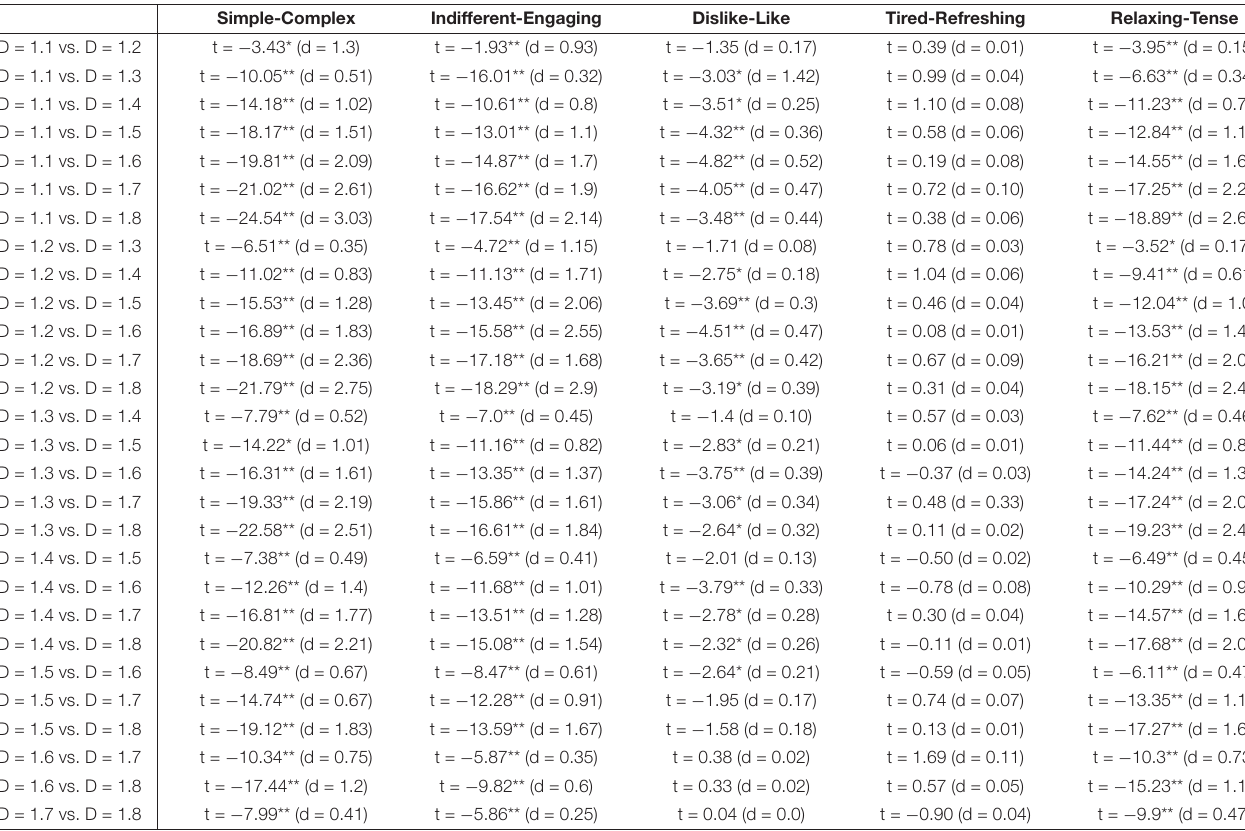
TABLE 2 | Experiment 1B- Paired Samples t -tests across D -value and Judgment. Simple-Complex